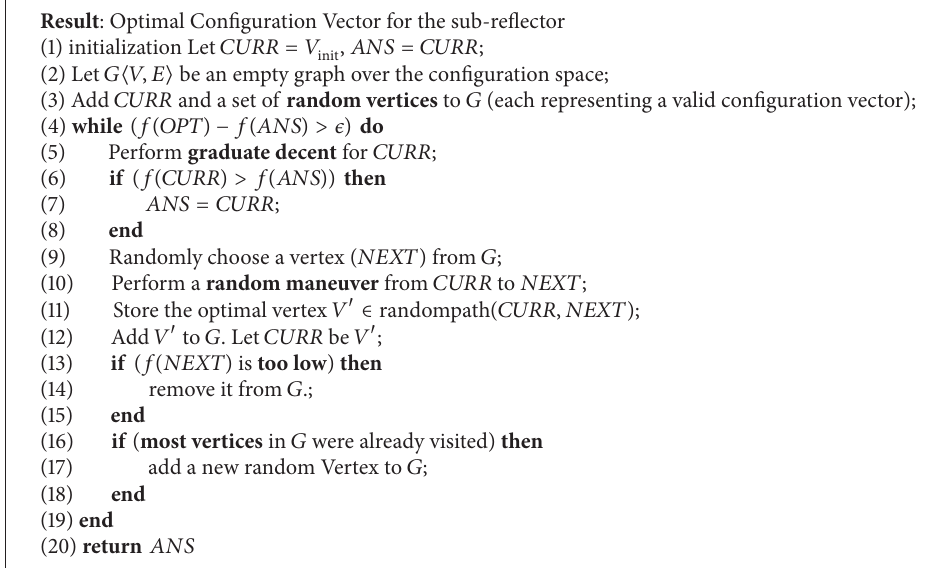
Algorithm 2: A generic algorithm for searching a maximal configuration